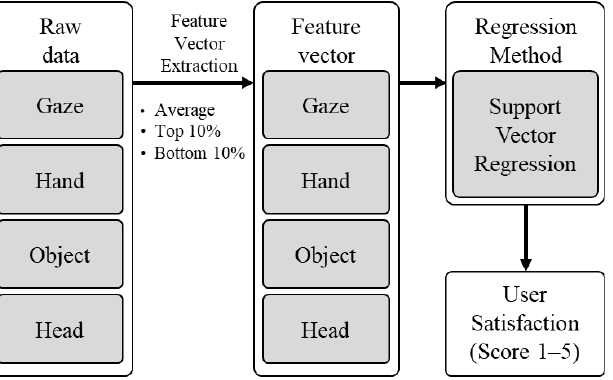
Figure 8. Process of converting interaction information to user satisfaction using SVR.